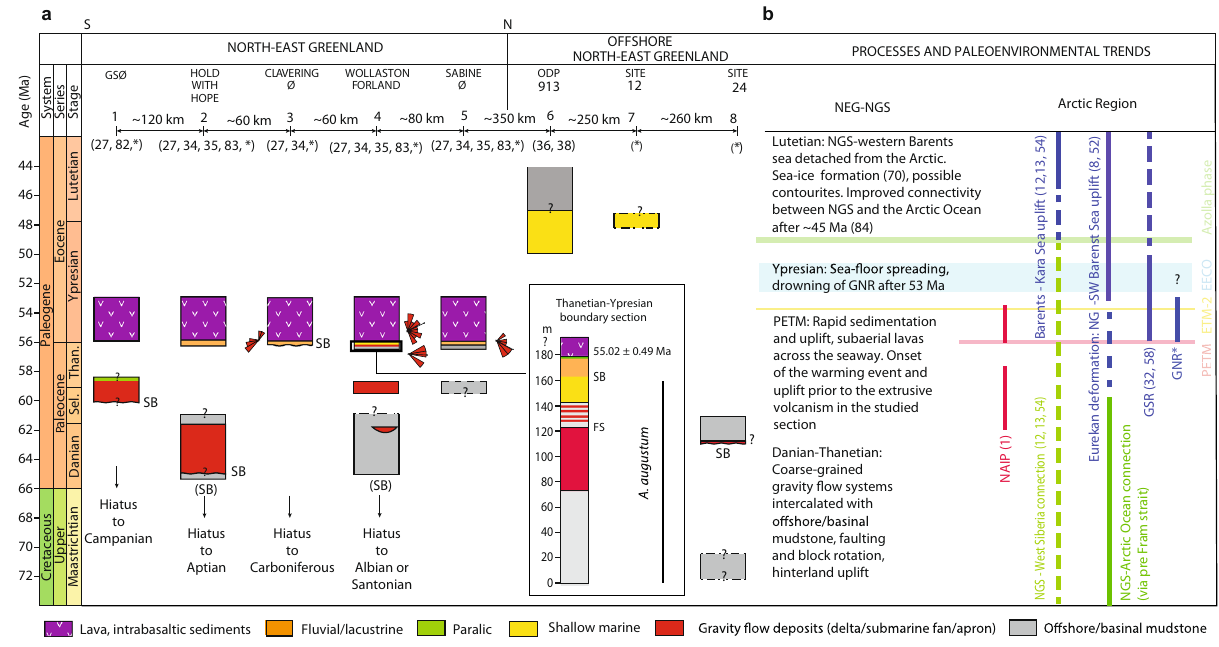
Fig. 2 Stratigraphy and paleoenvironmental trends. References used 1,8,12,13,27,32,34 – 36,38,52,54,58,70,82 – 84 are shown in parentheses. A star refers to locations described in this study. a Stratigraphic correlation panel of NE Greenland and offshore coring sites. See Fig. 1 for locations. Radiometric age of lava shown in the inset is from Larsen et al. 27 and represents the oldest lava in a nearby locality. GSØ, Geographical Society Ø; SB, Sequence boundary; (SB), inferred, Sel – Selandian, Than – Thanetian. b A summary of the main paleoenvironmental trends in NE Greenland (NEG) and estimated occurrence of main tectonic and magmatic events affecting connectivity of the Norwegian – Greenland Seaway (NGS) to other Arctic areas. EECO, early Eocene climate optimum; ETM2, Eocene Thermal Maximum 2; GNR, Greenland – Norway Ridge; GSR, Greenland – Scotland Ridge; NAIP, North Atlantic Igneous Province (main activity); NGS, Norwegian – Greenland seaway; PETM, Paleocene – Eocene Thermal